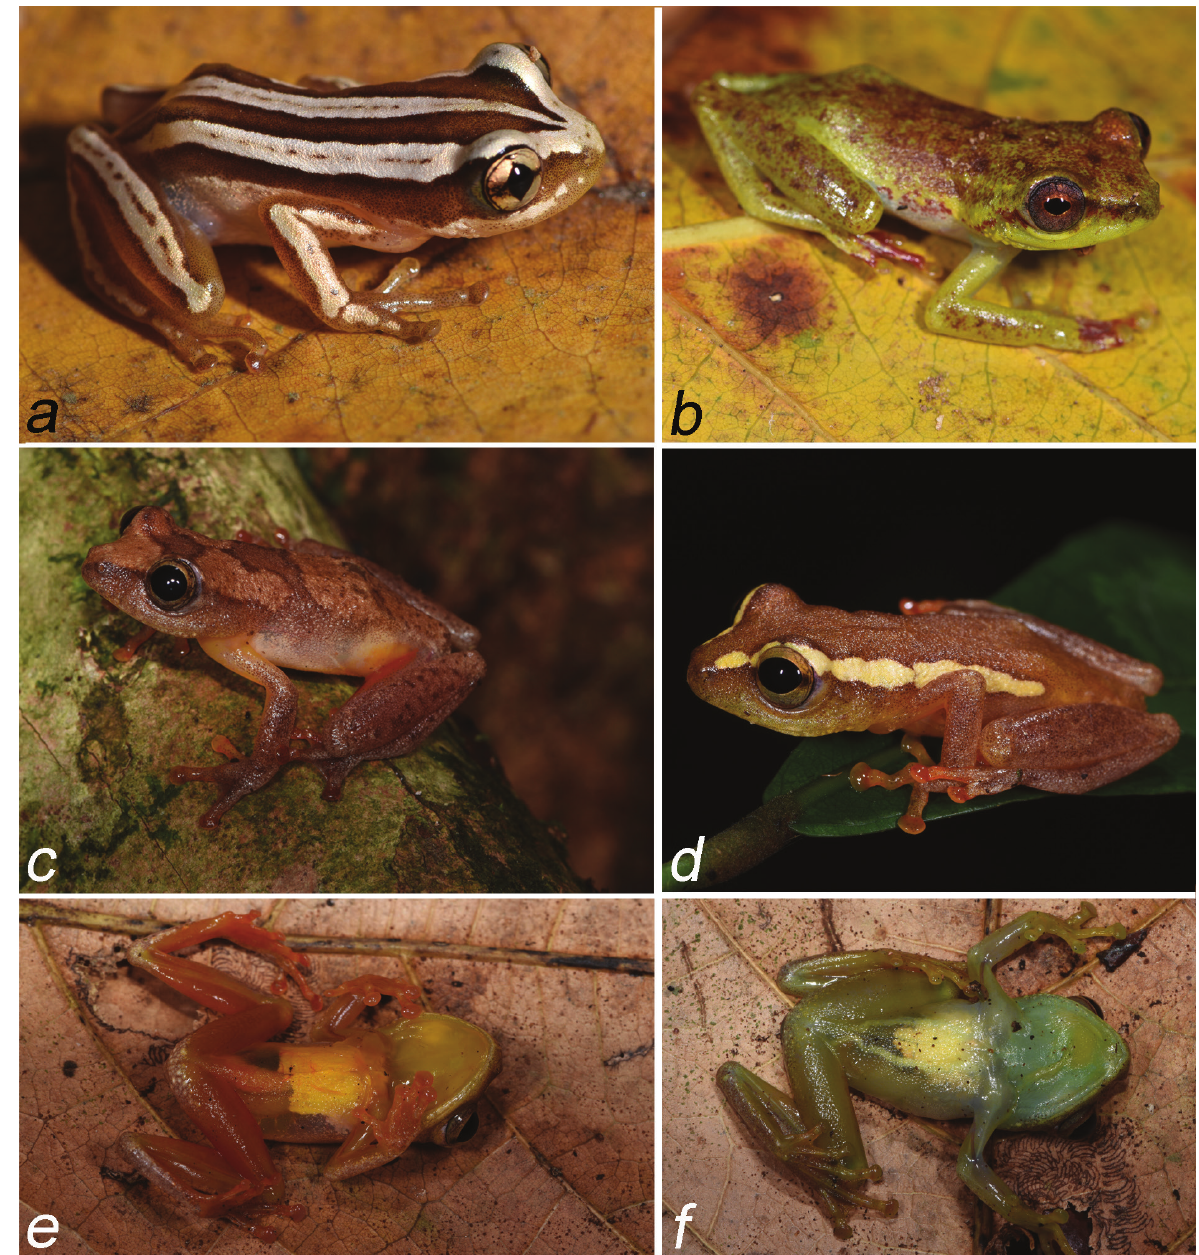
Figure 3. a Juvenile Afrixalus fulvovitattus (ZMB 88539) b Male Hyperolius soror (ZMB 88540), both from farmbush habitats in FPPA, note fine dark lines in the clear bands of A. fulvovittatus , the closely related A. vittiger is lacking these lines; c–f ) dorsal and ventral views of Hyperolius picturatus c Female (ZMB 88487) from KBPPA with hourglass pattern, a pattern also often found in combination with dorsolateral line in males d , e Female (ZMB 88464) from KBPPA with common brown back and broad yellow dorsolateral bands and yellow venter f Translucent greenish venter of male (ZMB 88465) from